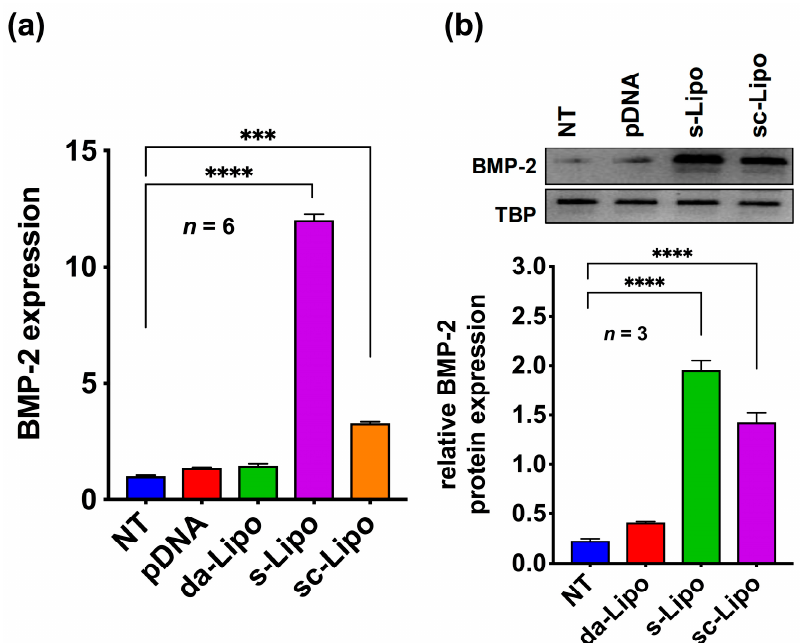
Figure 2. In vitro analysis of transfection of BMP-2 expressing plasmid DNA in hMSCs followed by encapsulation in HA-hydrogels. ( a ) Quantitative RT-PCR results indicating the expression levels of BMP-2 mRNA in hMSCs after 48 h of transfection in 3D. TBP was employed as an internal control to normalize BMP-2 mRNA expression. Gene expression values are stated as fold change relative to controls. Mean values ± SD of 2 independent experiments done in triplicates ( n = 6) are shown. Gene expression values are stated as fold change relative to controls. Statistical analysis was performed using one-way ANOVA with Bonferroni’s multiple comparison corrections (*** p < 0.0001, **** p < 0.00001). ( b ) Western blot analysis indicating BMP-2 protein levels after 72 h of transfection. BMP-2 and TBP-specific bands were quantified by ImageJ software and BMP-2 protein expression levels were normalized to TBP values. Mean values ± SD of 3 independent experiments are shown.The abbreviation NT = non-treated cells; pDNA = plasmid DNA alone; da-Lipo = direct addition of lipoplexes to MSC encapsulated in HA-hydrogel; s-Lipo = Lipofectamine TM 2000 assisted transfection of cells in suspension followed by encapsulation in HA-hydrogel; sc-Lipo = Lipofectamine TM 2000 assisted transfection of cells in suspension followed by centrifugation and subsequent encapsulation in HA-hydrogel; TBP = TATA-binding protein (**** p < 0,00001).